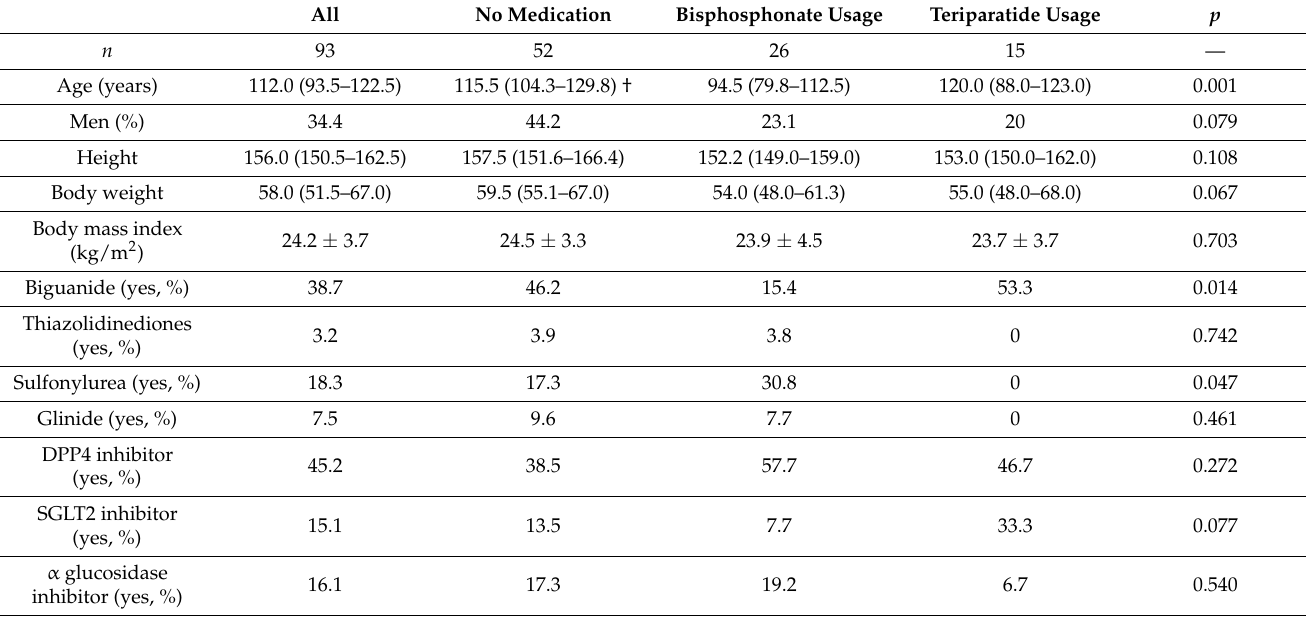
Table 1. Characteristics of study participants at the baseline examination.